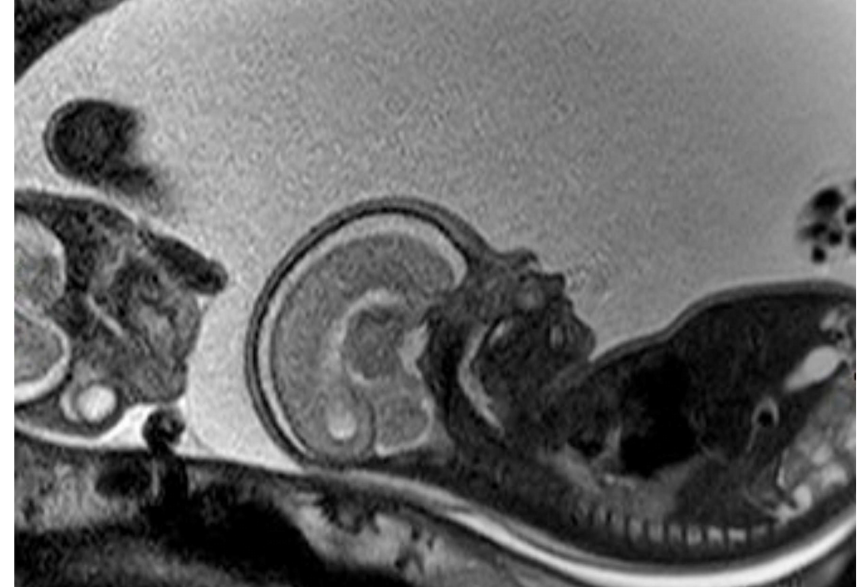
Figure 3. Fetal MRI at 25 weeks of gestation: the fetal MRI picture reveals the massive polyhydramnios. Due to the polyhydramnios of fetus II, fetus I provided a similar picture like a stuck twin, as it is found in a twin-to-twin transfusion syndrome, although fetal development and amniotic fluid have been normal in the second